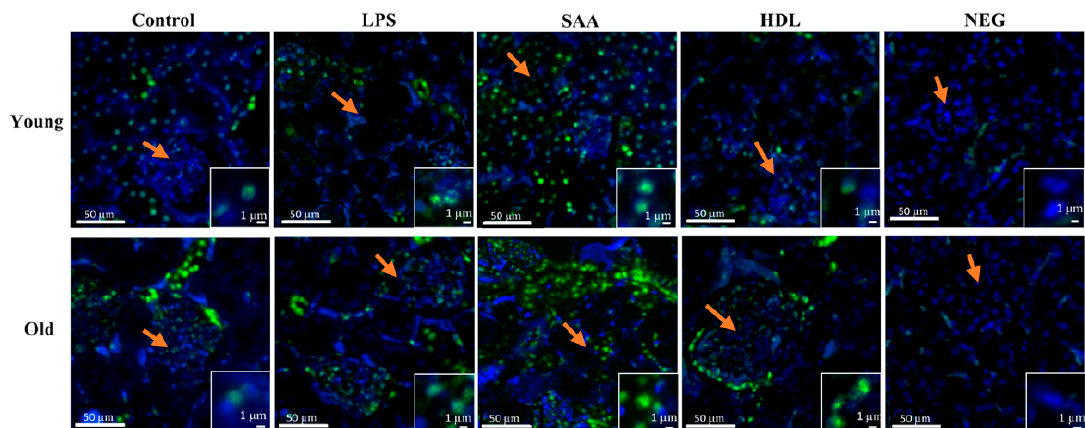
Figure 11. Pretreatment with HDL prevents SAA-mediated phosphorylated-p38 / MAPK increases in renal tissues. Mice were allocated into 4 treatment arms and administered with vehicle (control), LPS, SAA alone, or SAA in combination with HDL. Mice were monitored for 4 weeks (young cohort) or 18 weeks (old cohort) after commencement of treatment. At each time point, mice were sacrificed, and the kidneys were harvested and processed for immunohistochemistry, as described in the methods section. After antigen retrieval, kidney sections were fluorometrically labelled with p-p38 (green) and nuclei were stained with DAPI (blue). Figures are representative of n = 3 fields of view taken from n = 3 independent samples from each treatment group (including the negative control = secondary alone) at 20 × magnification. Insets to figures show higher magnification images of representative tubular epithelial cells from the di ff erent treatment groups. Orange arrows in the panels highlight glomeruli in the cortical region of each renal section.